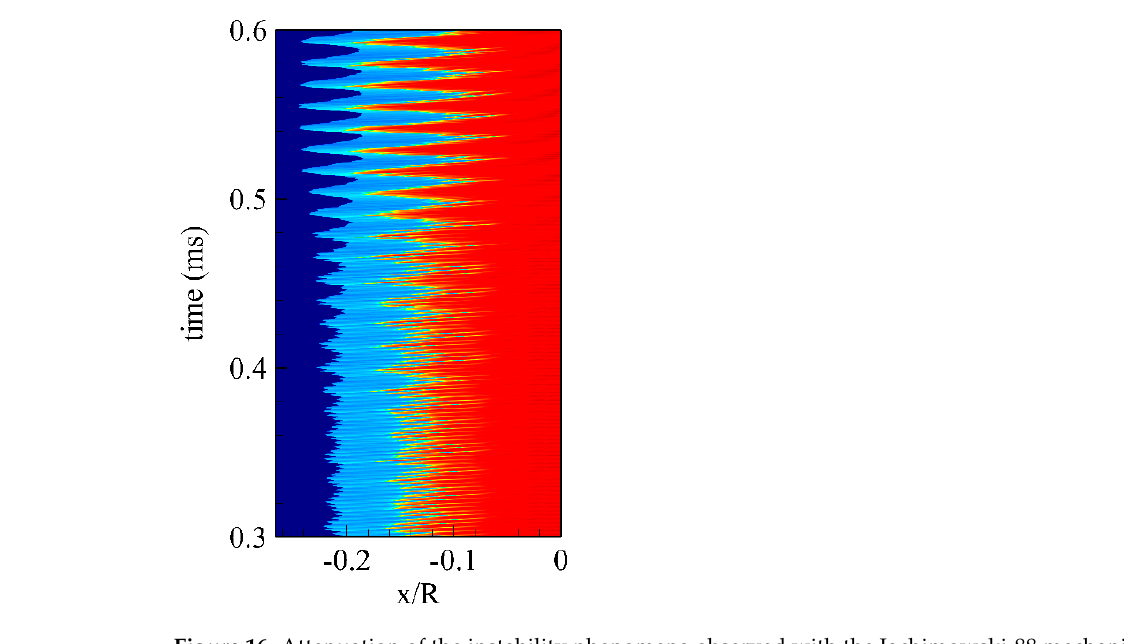
Figure 16. Attenuation of the instability phenomena observed with the Jachimowski - 88 mechanism at 400 × 600 grid system. Color scale is the same as Figure 9.